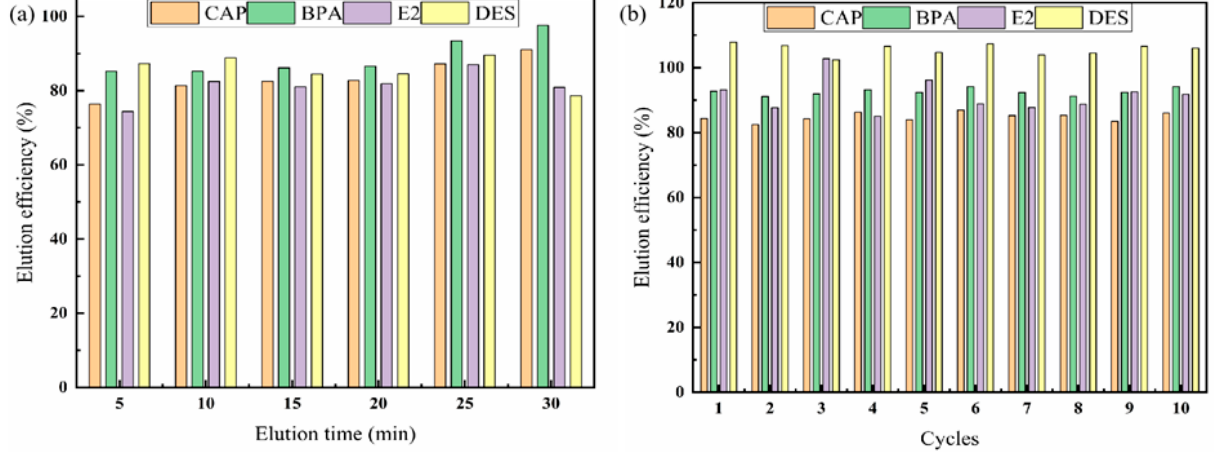
Figure 4. Effect of elution time ( a ) on the recoveries of CAP, BPA, E2, and DES. The reusability of Fe 3 O 4 @MIL-53(Al) ( b ).